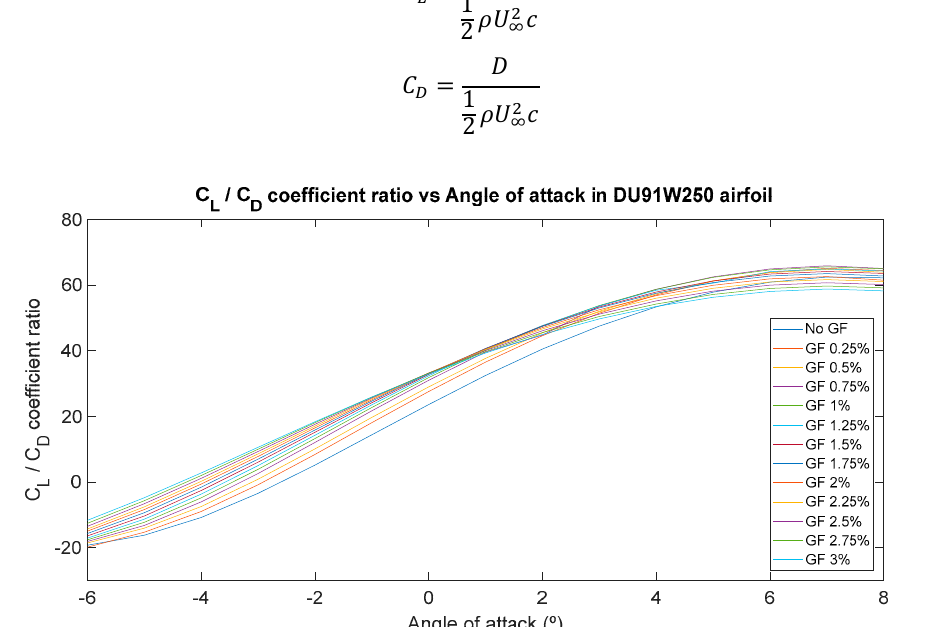
Figure 3. Lift coefficient vs Angle of attack in DU91W250 airfoil for different GF length